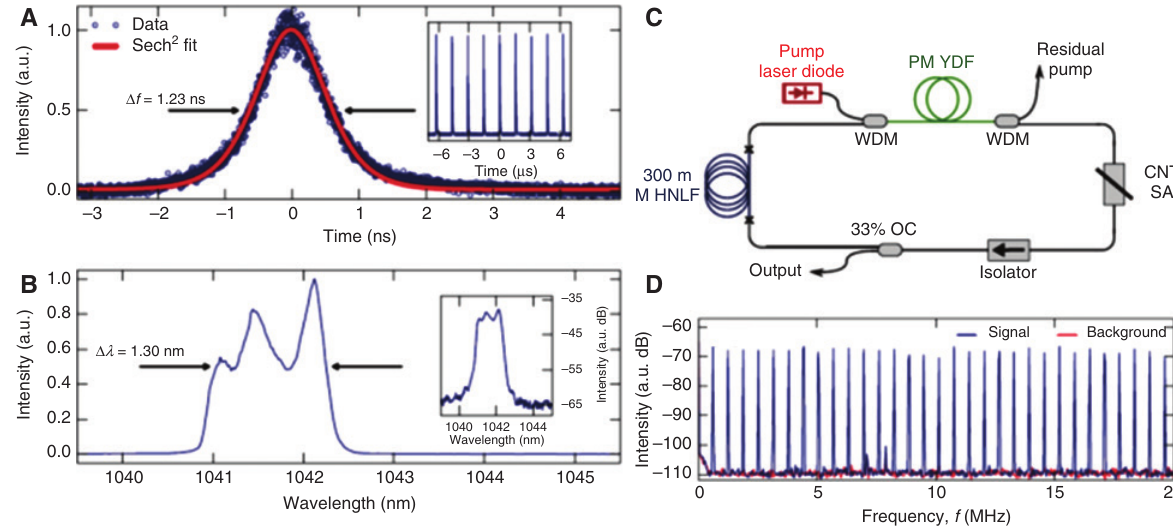
Figure 13: A typical low repetition rate fiber laser based on CNT SA. (A) Streak camera trace (inset: pulse train on oscilloscope). (B) Optical spectrum on linear scale (inset: log scale). (C) Schematic setup of laser cavity: YDF – ytterbium-doped fiber; WDM – wavelength division multiplexer; CNT SA – nanotube-based saturable absorber; OC – output coupler; HNLF – highly nonlinear fiber and (D) RF spectrum of laser output in the span of 20 MHz. Woodward et al. [173] © IEEE